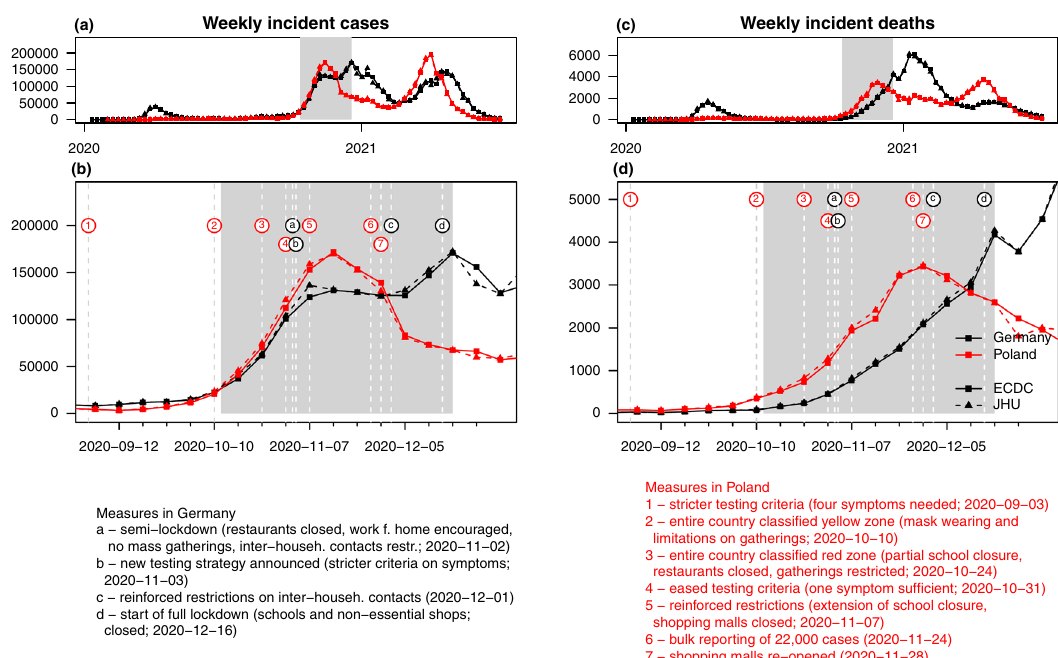
Fig. 1 Forecast evaluation period. Weekly incident ( a , b ) con fi rmed cases and ( c , d ) deaths from COVID-19 in Germany and Poland according to data sets from the European Centre for Disease Prevention and Control (ECDC) and the Centre for Systems Science and Engineering at Johns Hopkins University (JHU). The study period covered in this paper is highlighted in grey. Important changes in interventions and testing are marked by letters/numbers and dashed vertical lines. Sources containing details on the listed interventions are provided in Supplementary Note